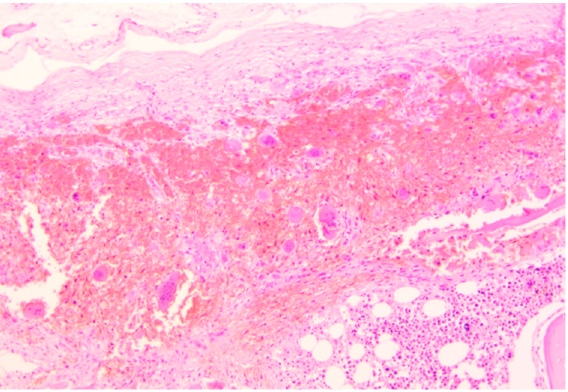
Figure 3. Skullcap erosion, parietal bone. H&E staining—magnification 40×. Immediately below the external theca of the bone cap is present a large osteolytic hotbed, bone tissue with massive demineralization replaced by granulation tissue, and massive red blood cell infiltration.